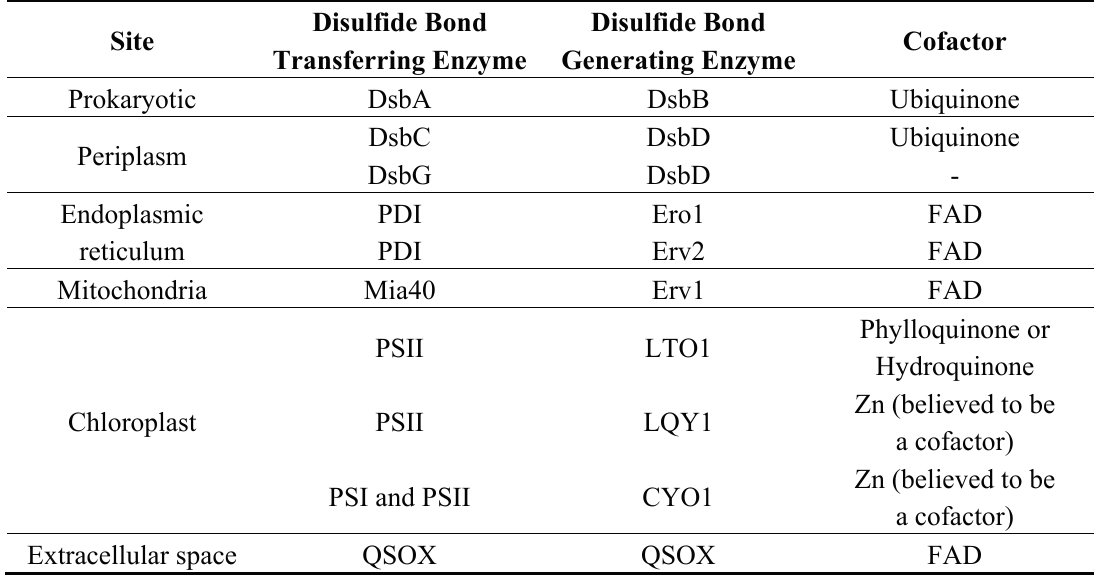
Figure 2. Cellular representation of enzyme systems and respective organelles. Table 1. Cellular compartments and enzyme systems for disulfide bond